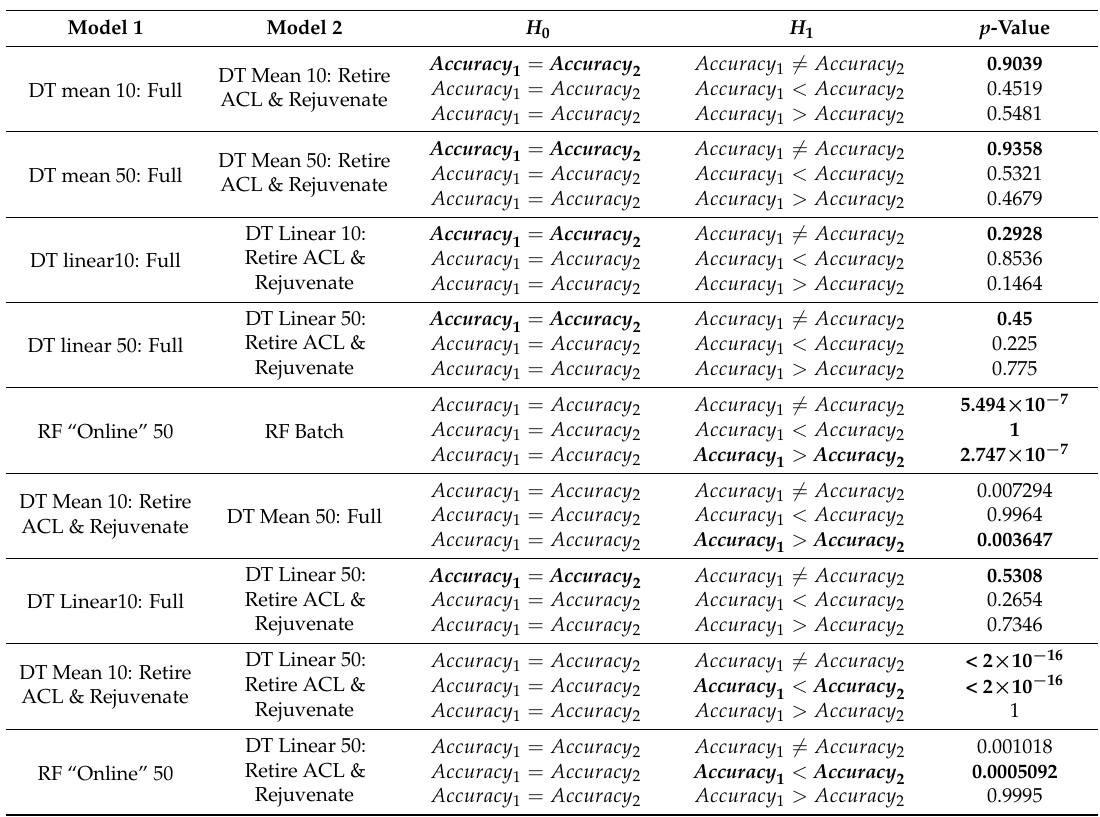
Table 8. One-hour ahead forecast results for the Diebold-Mariano